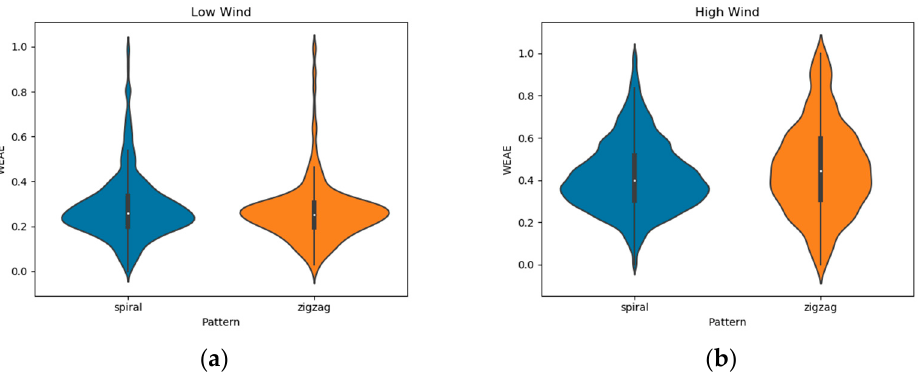
Figure 7. Influence of each flight pattern separated between: ( a ) Low Wind, gathered on June 15, and ( b ) High Wind, gathered on June 20.